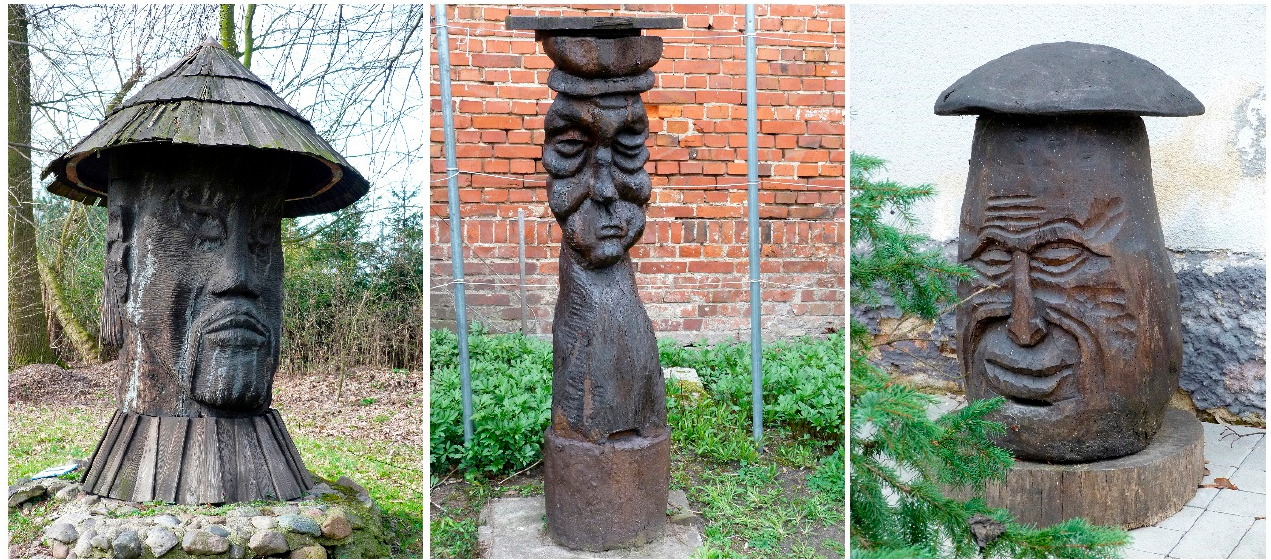
Figure 1. Three examples of wooden beehives from the collection of The Museum of Apiculture in Swarz ę dz, a branch of The National Museum of Agriculture and Food Industry in Szreniawa, Poland; from the left: a beehive No. MS E-128 called “Chinese”, a beehive No. MS E-63 called “The Priest”, a mushroom-shaped beehive No. MS E-242.